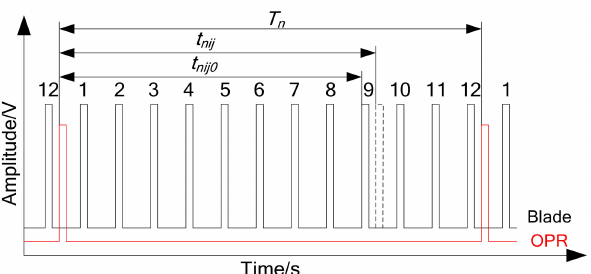
Figure 3. Pulse signal sequence for one blade passing probe and once per revolution